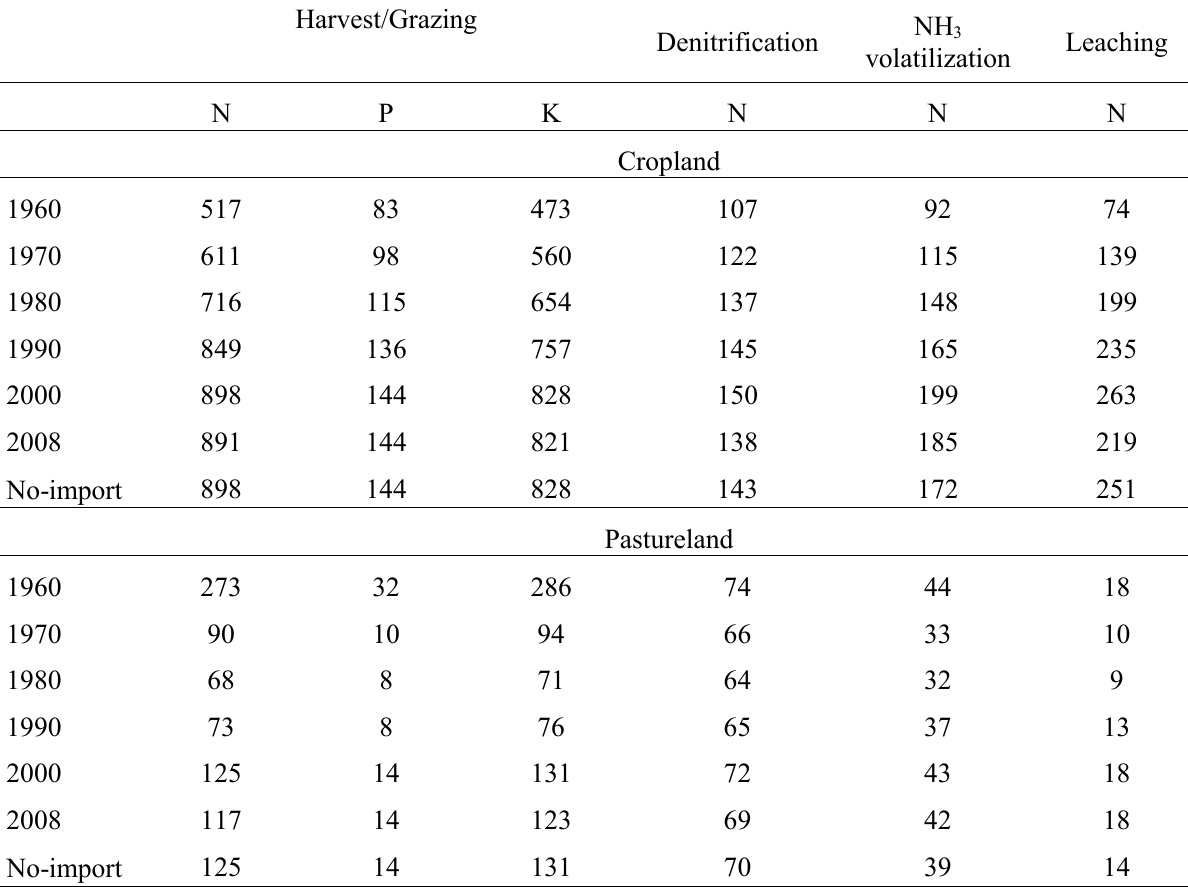
Table A1.5. Outputs of N, P and K in Spanish cropland and pastureland